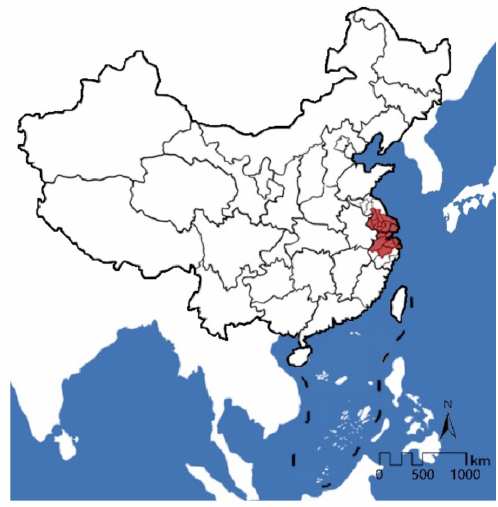
Figure 2. Location of the study area in